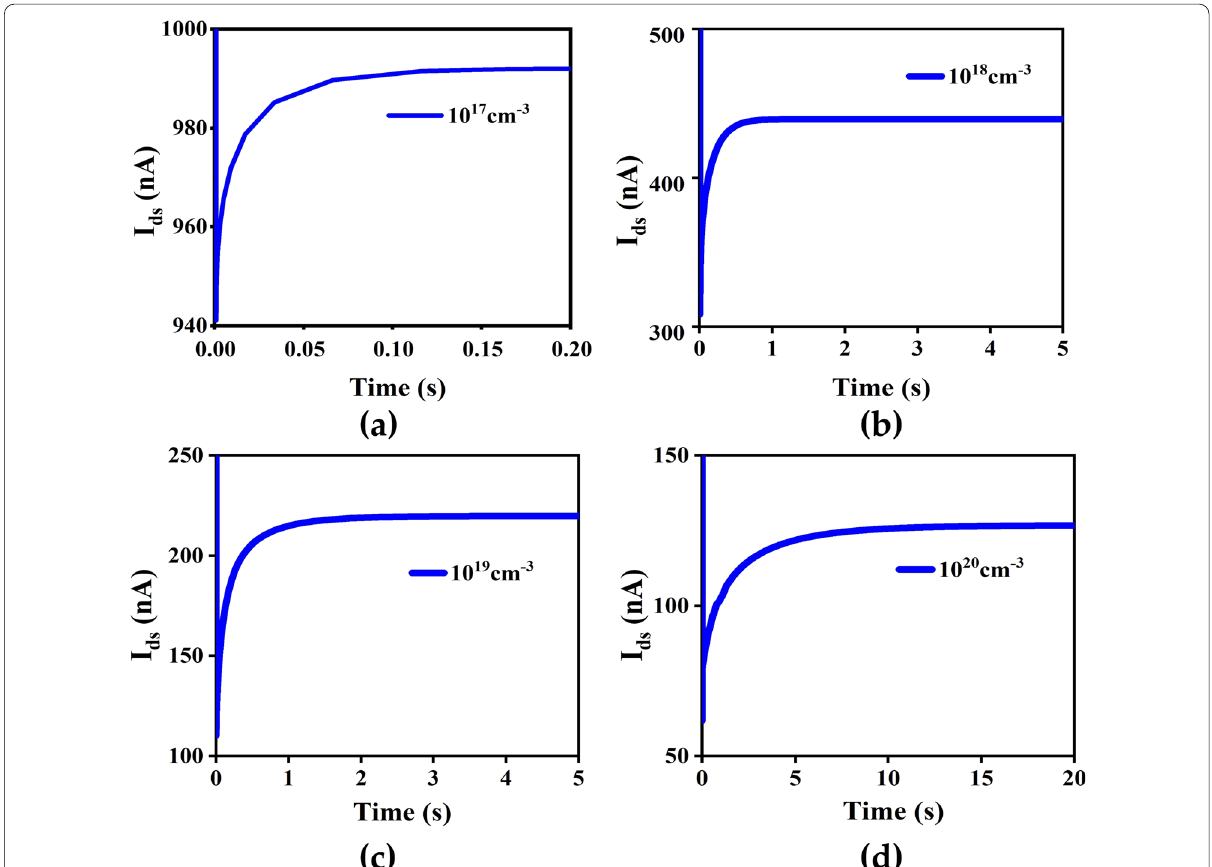
0.5 V. The amplitude and width of the =